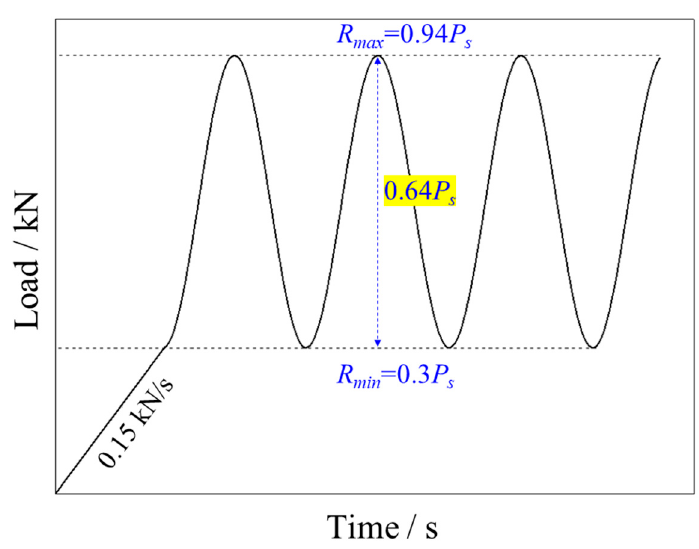
Figure 4. Schematic of force history in CPL tests. Table 1. Test parameters and results in CPL testing with di ff erent loading frequencies.